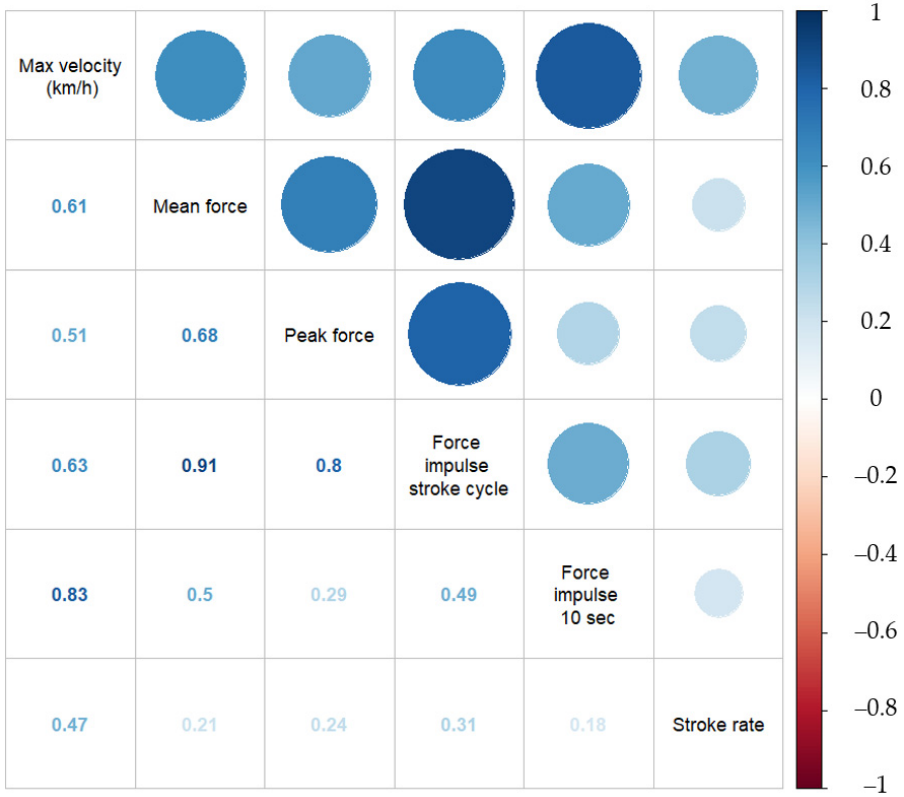
Figure 4. Correlation matrix with correlation coefficients between the maximum velocity and leg force variables (mean force, peak force, force impulse during one stroke cycle, force impulse over 10 s, stroke rate, and group) for 25 paddlers. The coloring indicates different levels of correlations, with dark blue indicating a strong positive correlation, white denoting no correlation, and dark red a strong negative correlation.